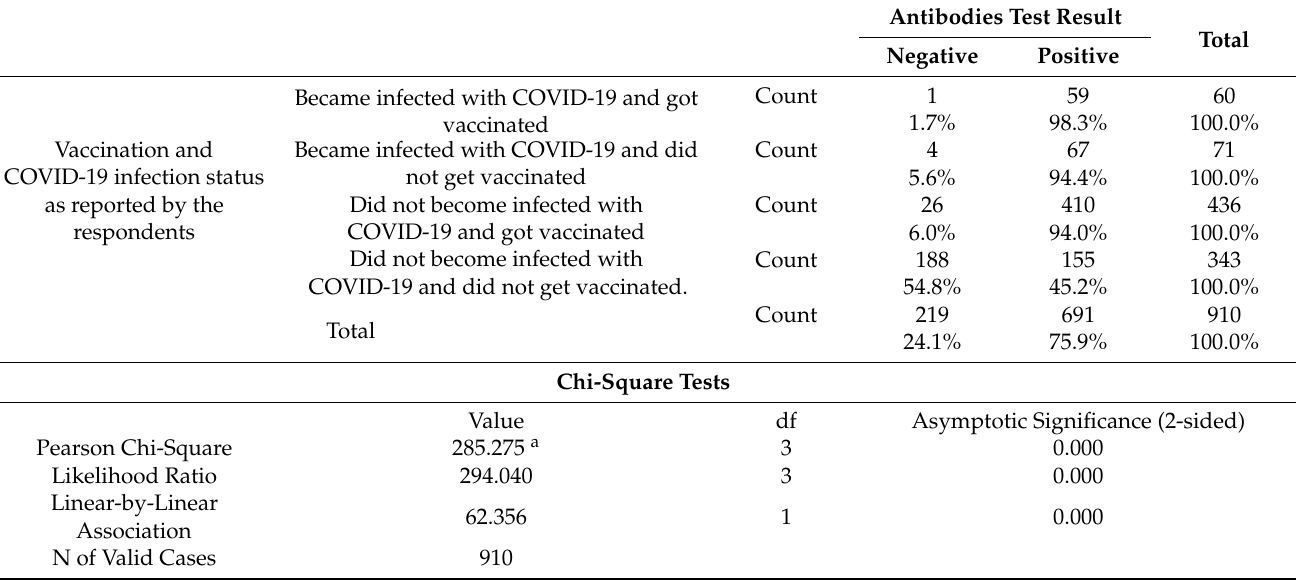
Table 6. Antibodies test results by vaccination and COVID-19 infection status as reported by respondents.